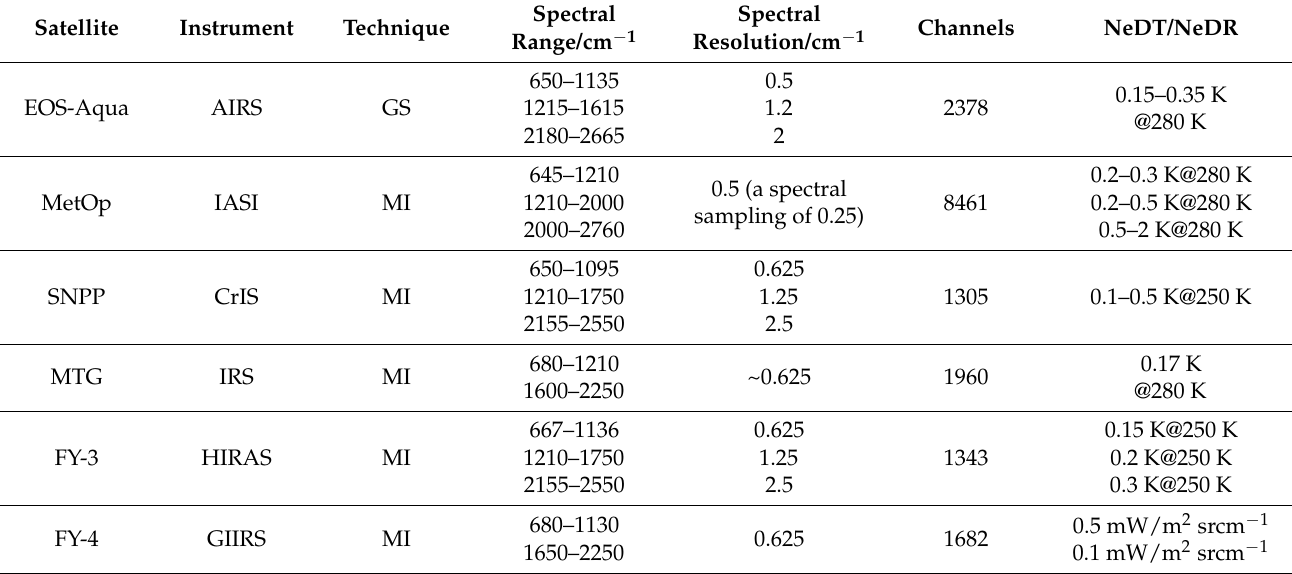
Table 1. The parameters of spaceborne hyperspectral infrared atmosphere vertical